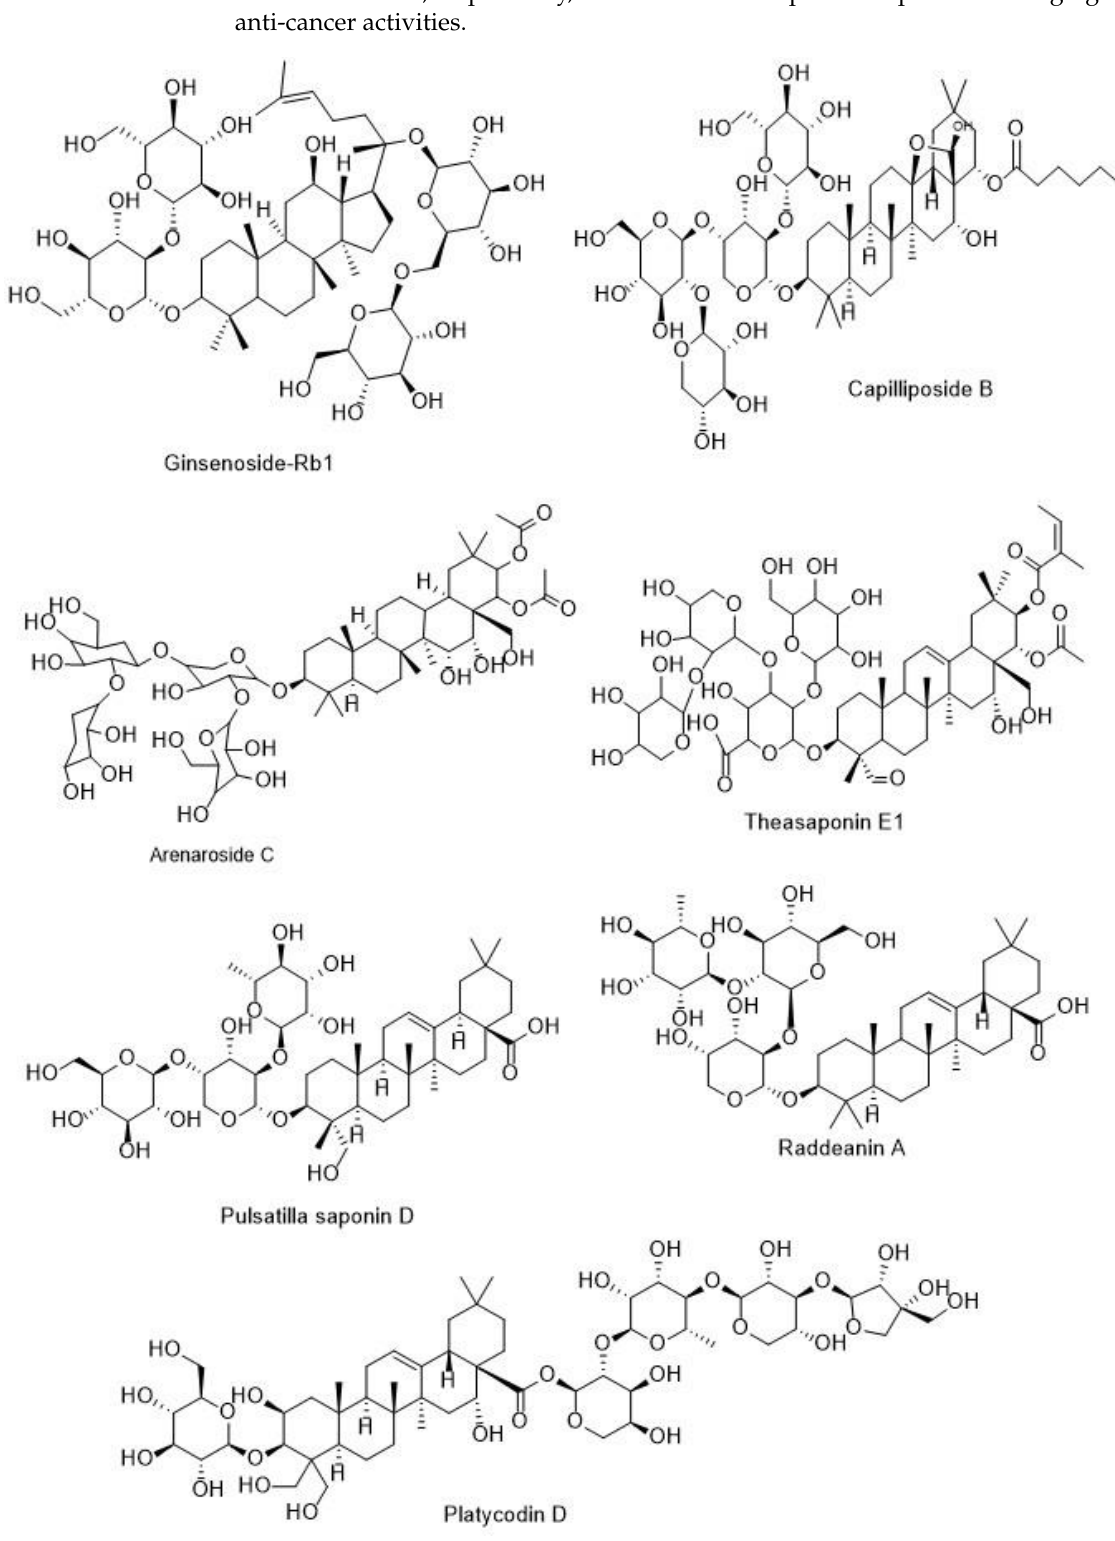
Figure 5. Chemical structure of some anti-angiogenic triterpenoid saponins .